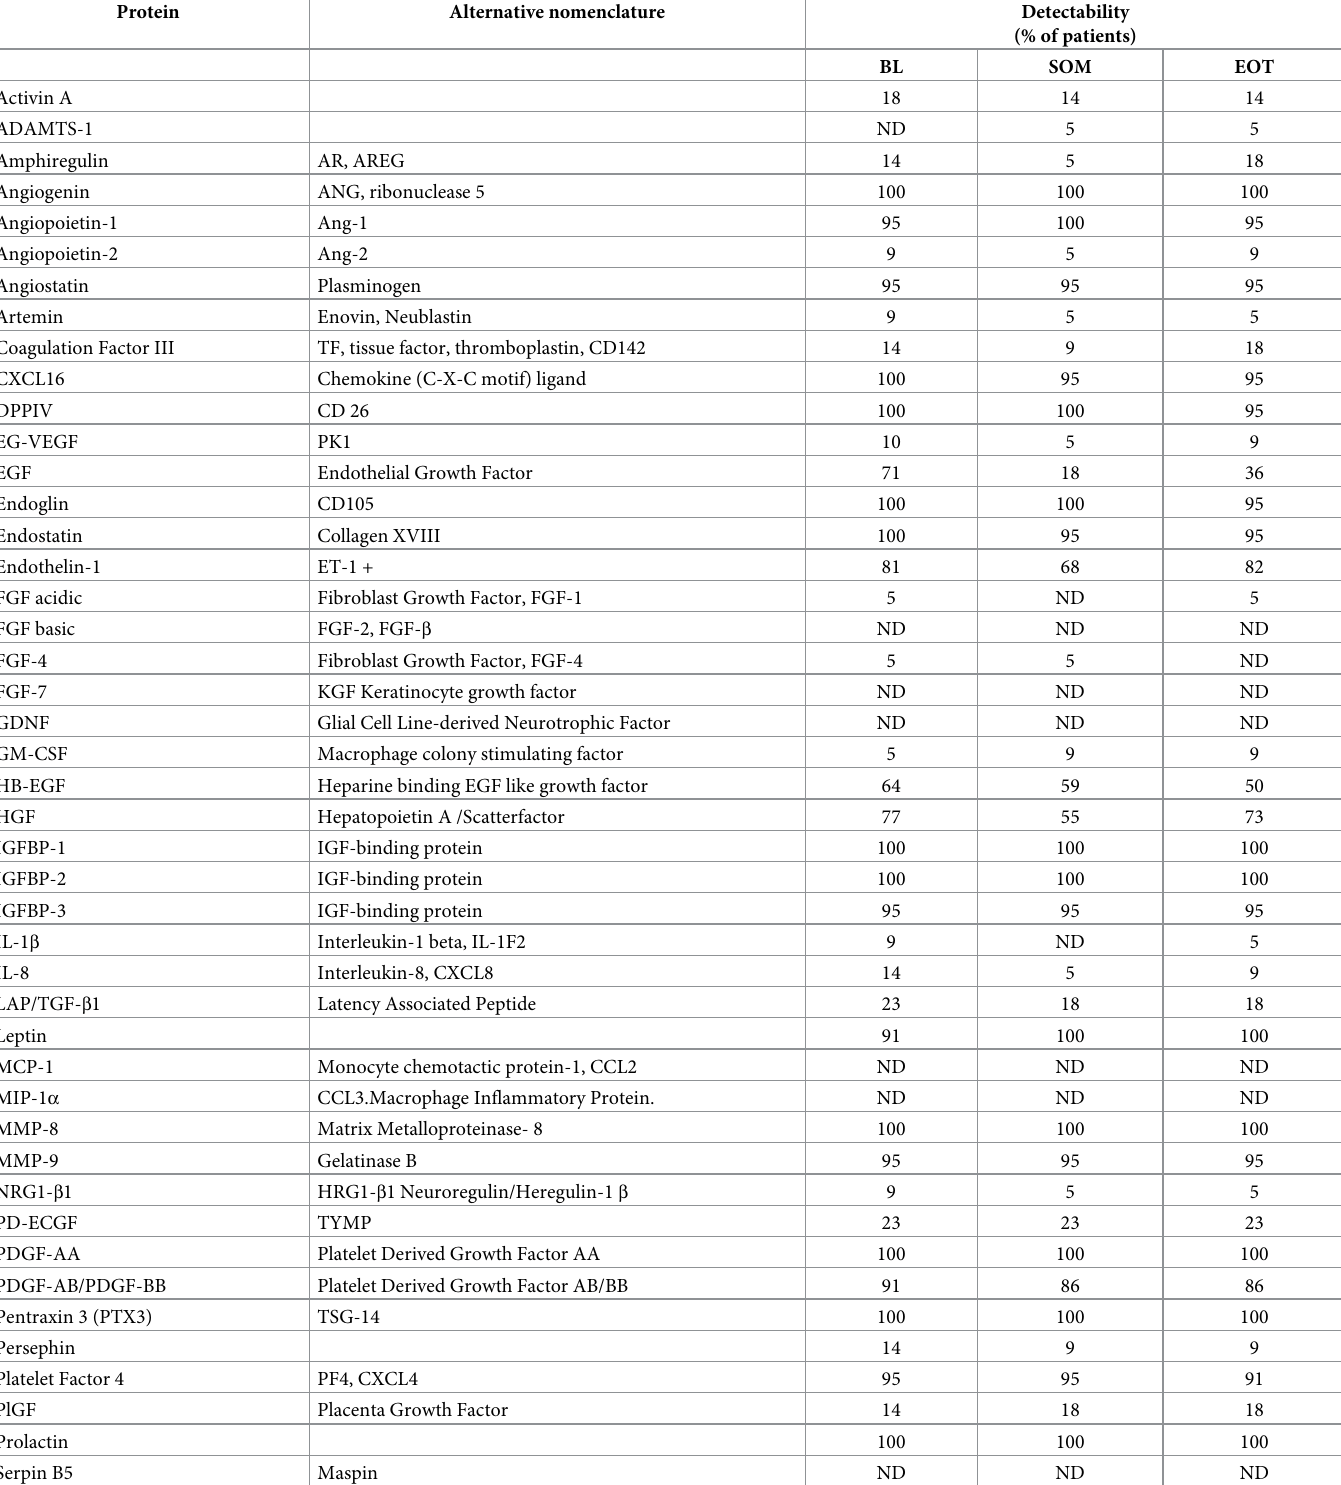
Table 1. Detection of angiogenic factors in the protein array patient cohort (n=22 patients).